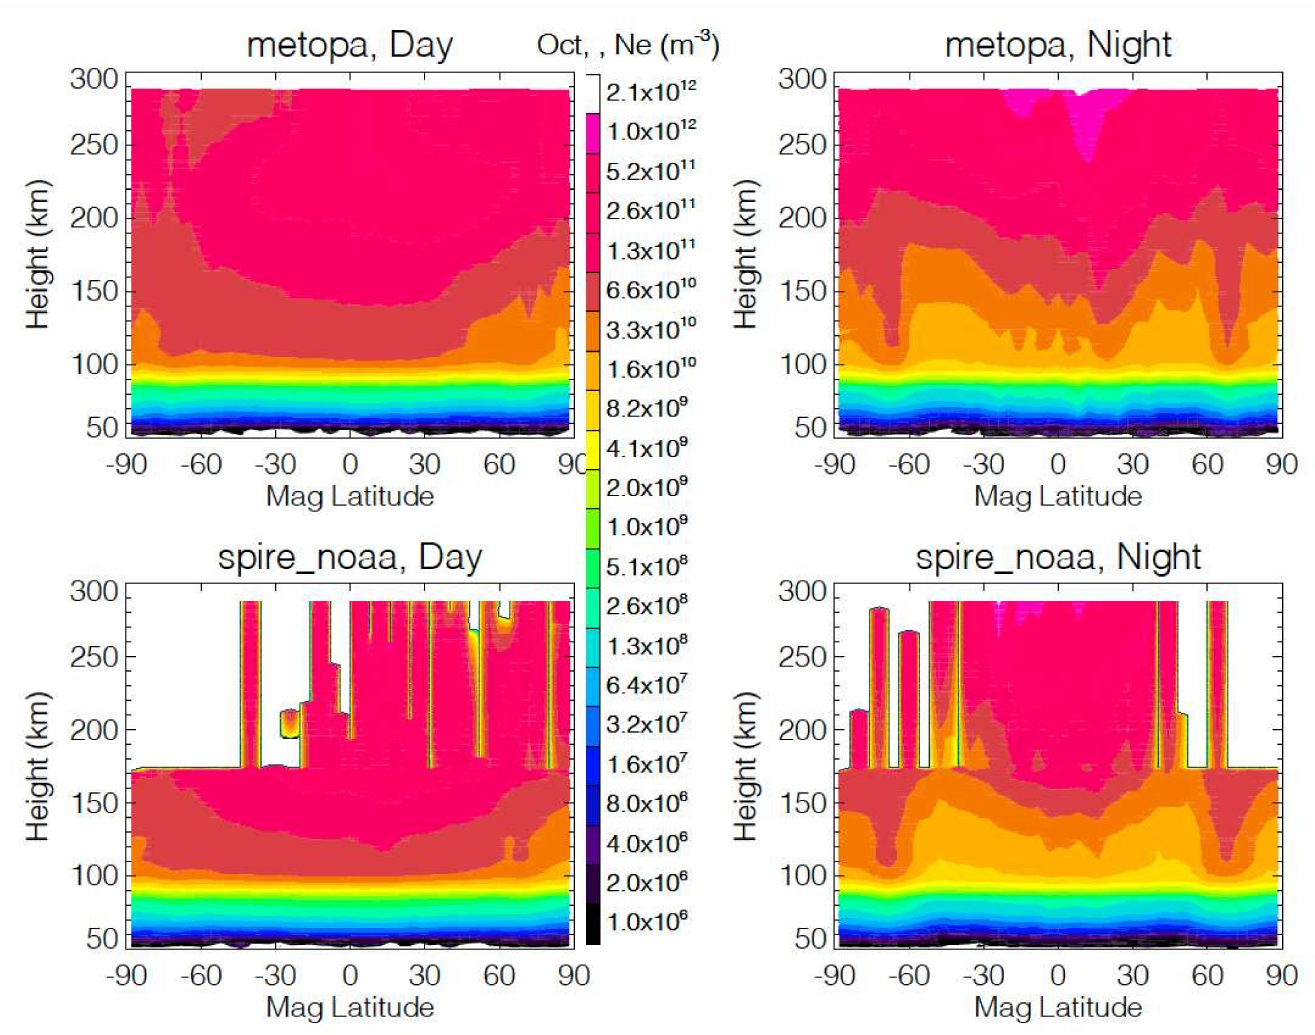
Figure 6. Zonal mean N e profile from MetOp-A (top panels) and Spire (bottom panels) as a function of magnetic latitude for October